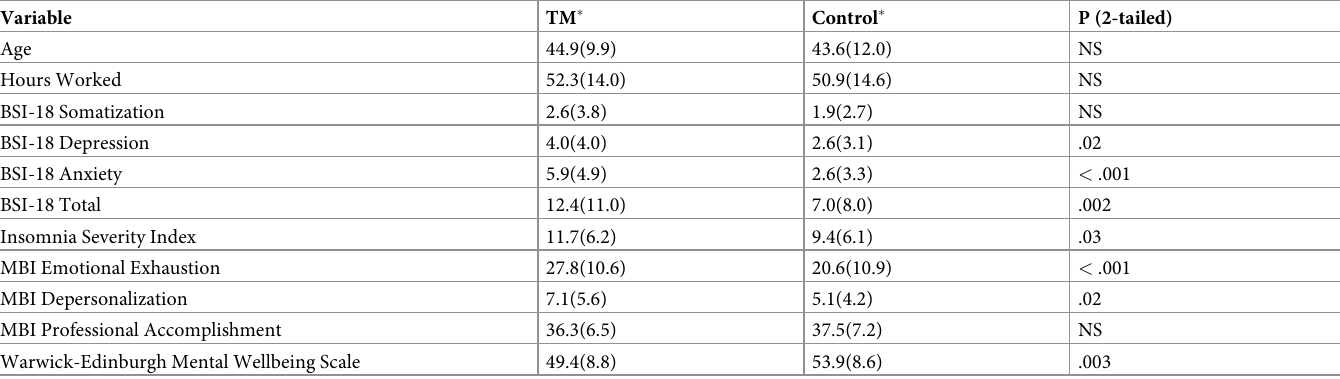
Table 2. Comparison of groups at baseline on the continuous study